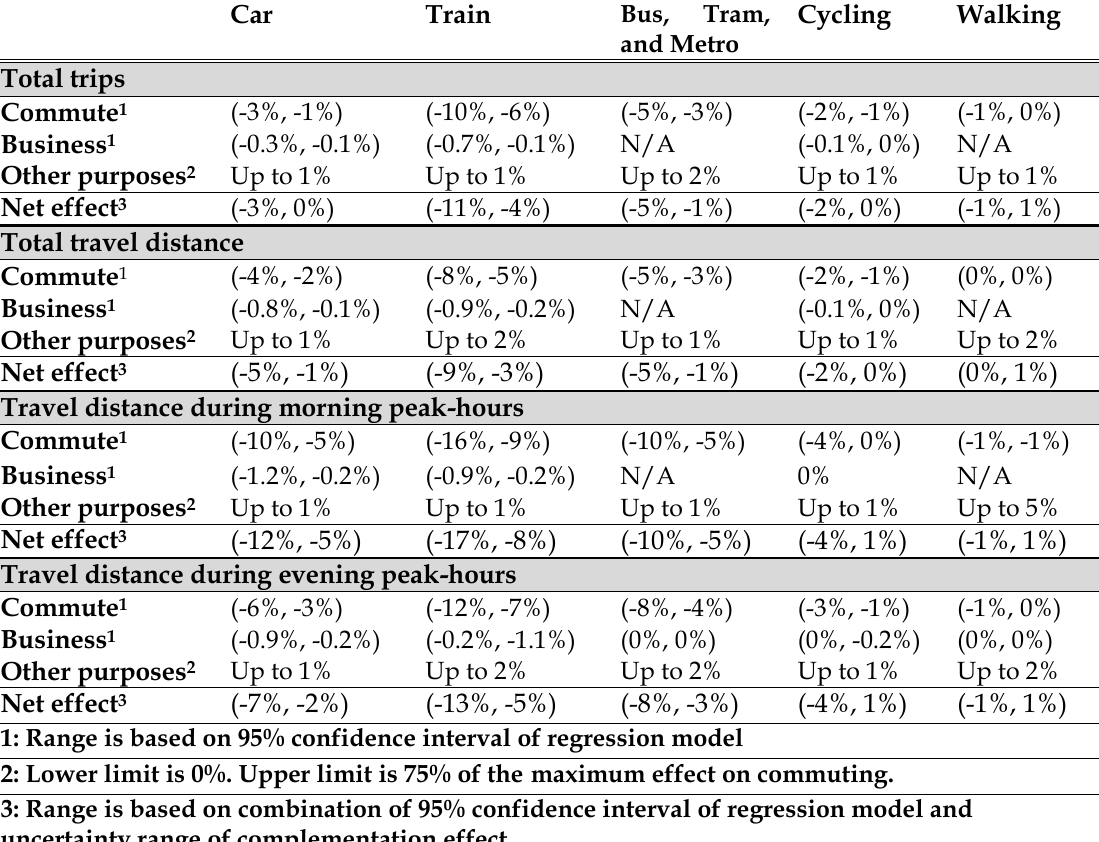
Table 5. Expected range of changes in total travel due to working from home and teleconferencing per mode (Results based on MPN estimates, projected using ODiN data to get national-level statistics for total travel